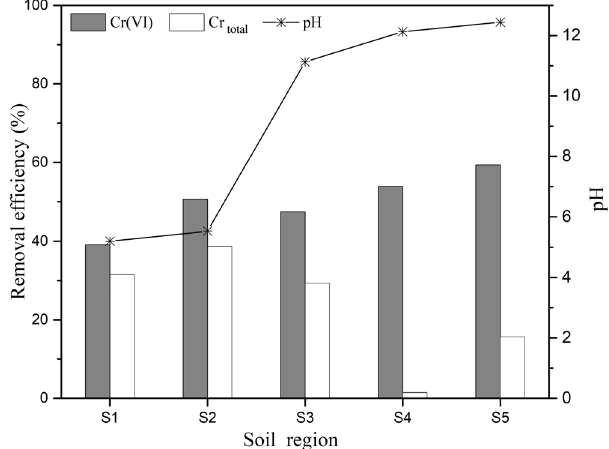
Figure 4. Removal efficiency and pH in the 2D EKR